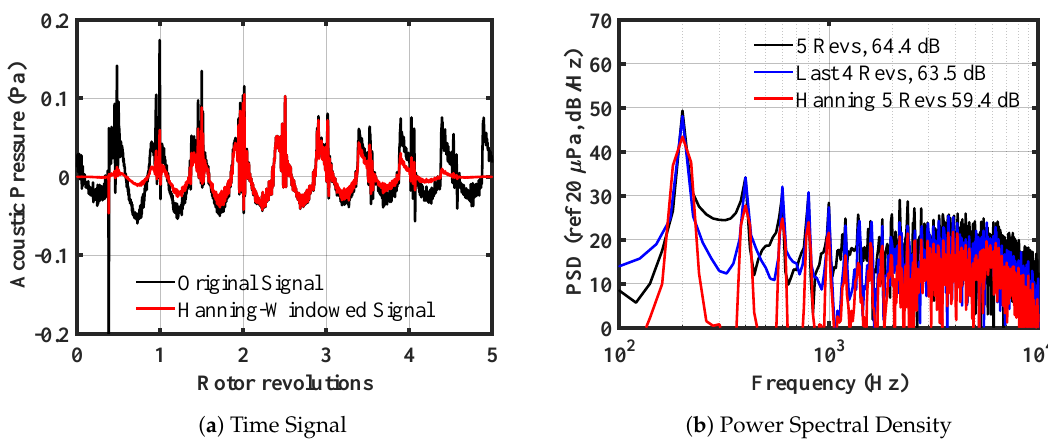
Figure 4. The acoustic pressure time history and acoustic spectra of dual rotors in hover at an above-plane observer, using Helios/PSU-WOPWOP. The acoustic pressure spectra are computed using the different postprocessing techniques. The resulting overall sound pressure level is shown in the